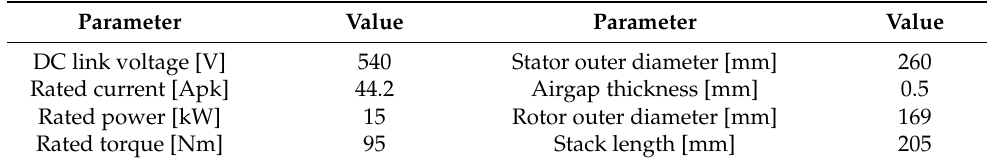
Table 1. SynRel rated